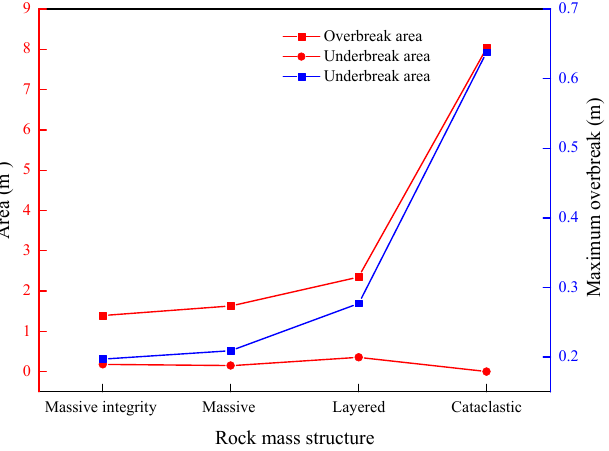
Figure 7. Relationship between overbreak and underbreak and rock mass structure